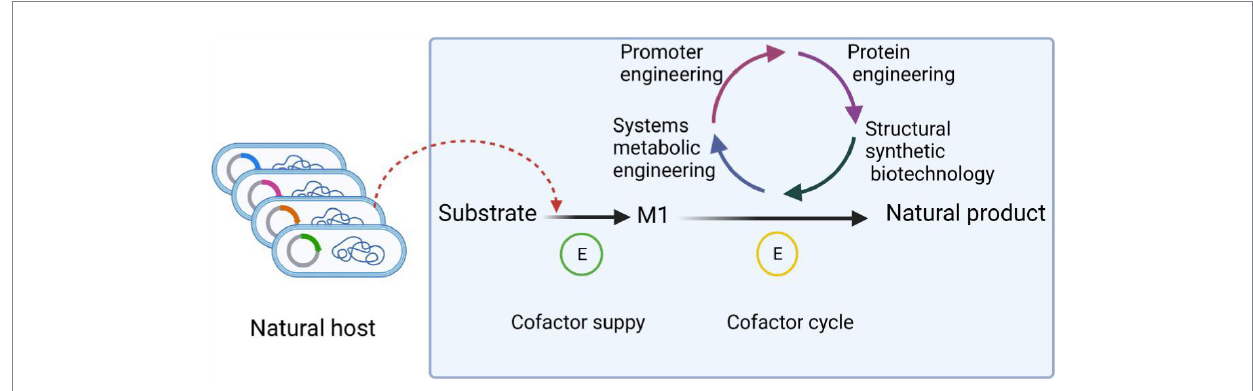
FIGURE 2 Process of product production in microbial metabolism. Cofactors play an important role in biosynthesis. First of all, the substrate was used to generate M1, which is necessary for the growth of microorganisms, through the combined action of cofactors, etc. The precursor M1 is then used as the precursor to synthesize substances with more complex chemical structure and no obvious physiological function for the microorganism. The cofactors of the whole synthesis process can be regulated by promoter engineering, protein engineering, structural synthetic biotechnology, system metabolic engineering and so on. These strategies make cofactor transition quickly and help to improve the cofactors